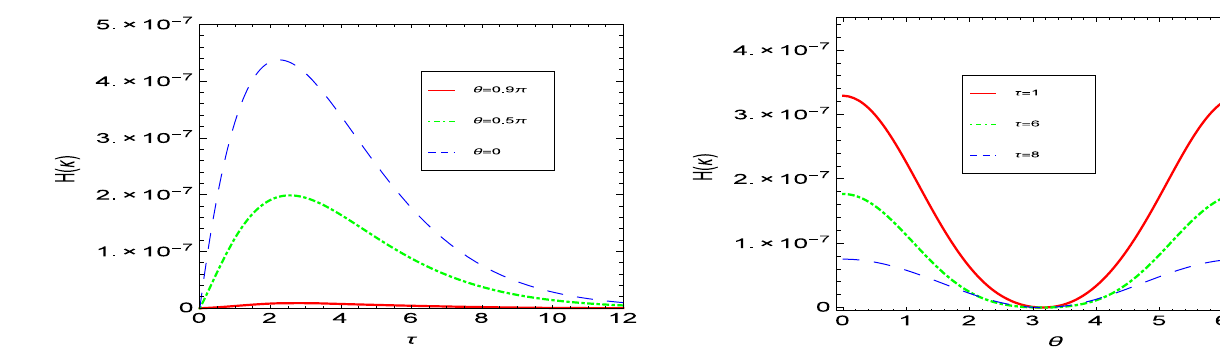
Fig. 4 QFIintheestimationofthedeformationparameterasafunction of the effective time τ with fixed values of θ . The effective deformation parameter is fixed as κ = 1000, the velocity of detector is given by v = 0 . 9994 and the effective centripetal acceleration a = 0 . 2. The different initial state parameter θ = 0 , 0 . 5 π, 0 . 9 π , respectively